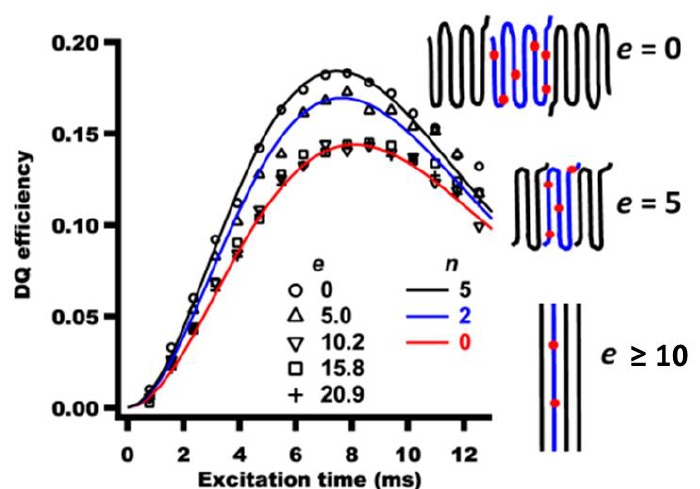
Figure 14. 13 C – 13 C DQ buildup curves of 13 C 50 wt% labeled i PP α 1 crystal blends with non-labeled one at a mixing ratio of 1:9 at different e values and calculated DQ curves with different < n > values. Schematic illustrations of chain-folding numbers as a function of e . (Reprinted with permission from ACS Macro Lett . 2016 , 5 , 65 – 68. Copyright (2016) American Chemical Society).